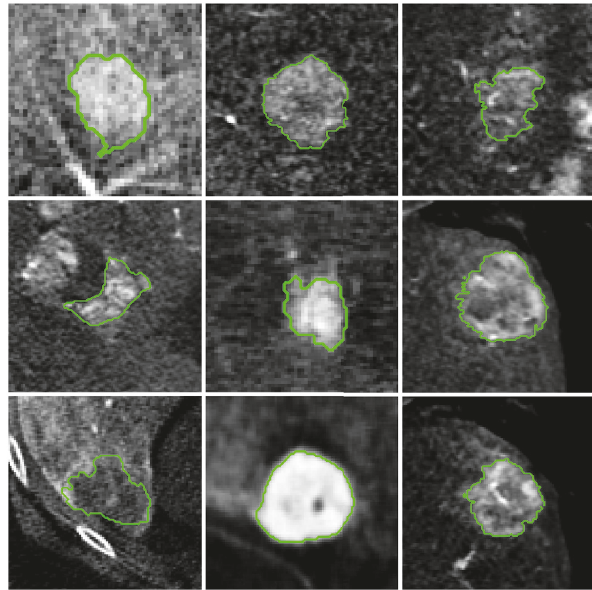
Figure 1: Liver lesion segmentations. Depicted are central slices through the volumes of interest of reconstructed images acquired by a C-arm CBCT scanner. The manually annotated ground truth segmentation is displayed as an overlay contour line in